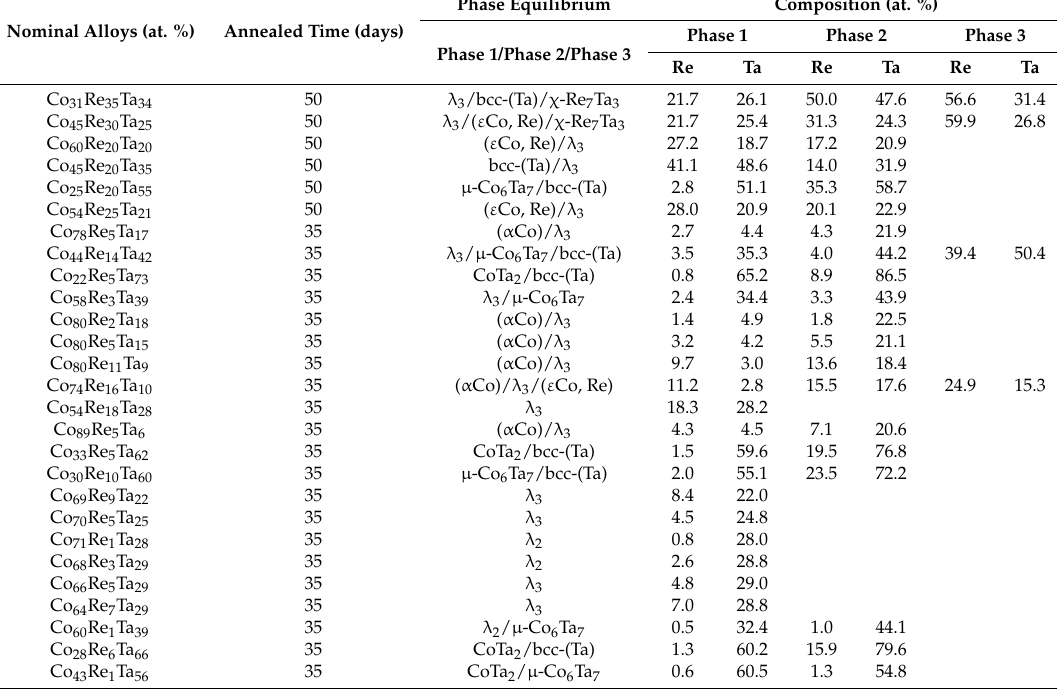
Table 3. Equilibrium compositions of the Co-Re-Ta ternary system at 1200 ◦ C as determined in the present